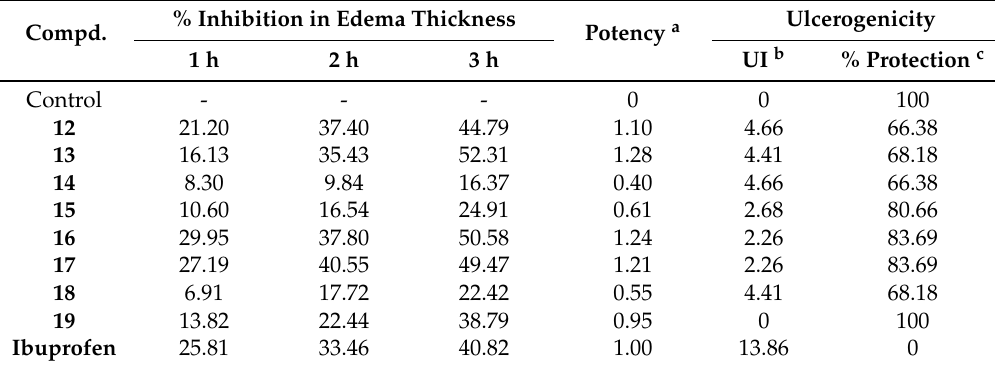
Table 2. The anti-inflammatory activity (% inhibition of edema thickness) and ulcer indices of compounds 12 – 19 .